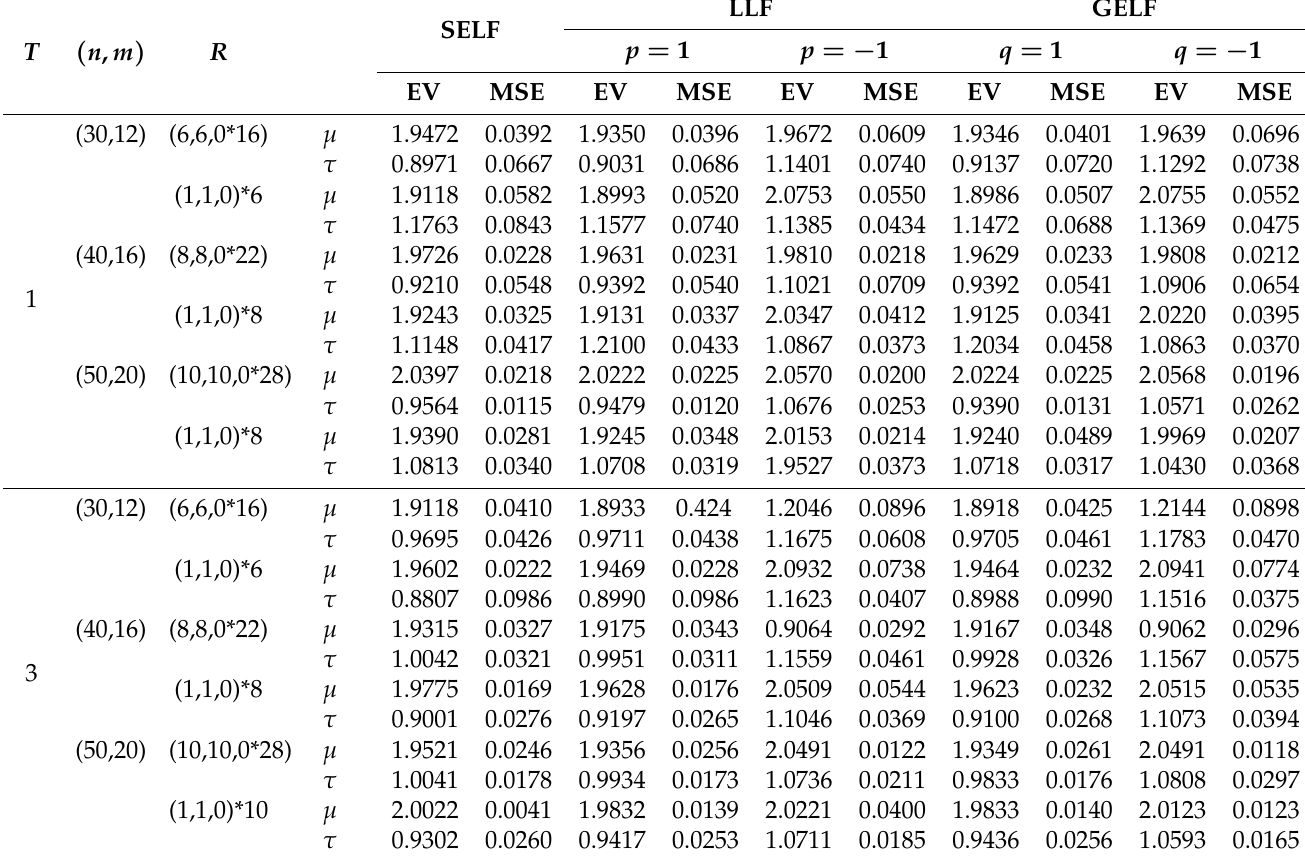
Table 3. The Bayesian estimation results of µ and τ by applying Lindley approximation under SELF, LLF and